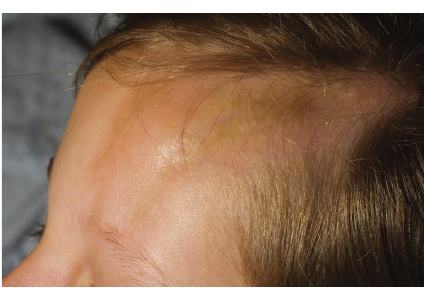
Figure 2: Morphea en coup de sabre.